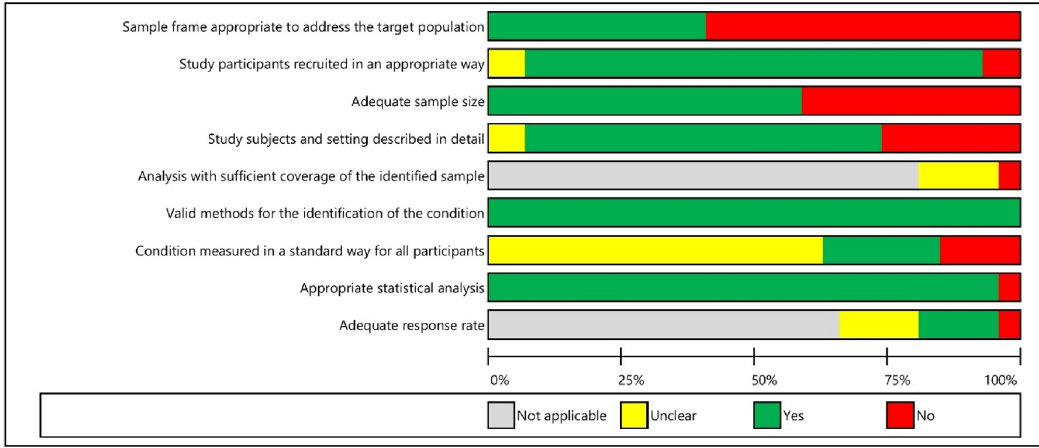
Figure 2. Risk of bias: reviewers’ judgements about each risk of bias item across all included studies. Presented as